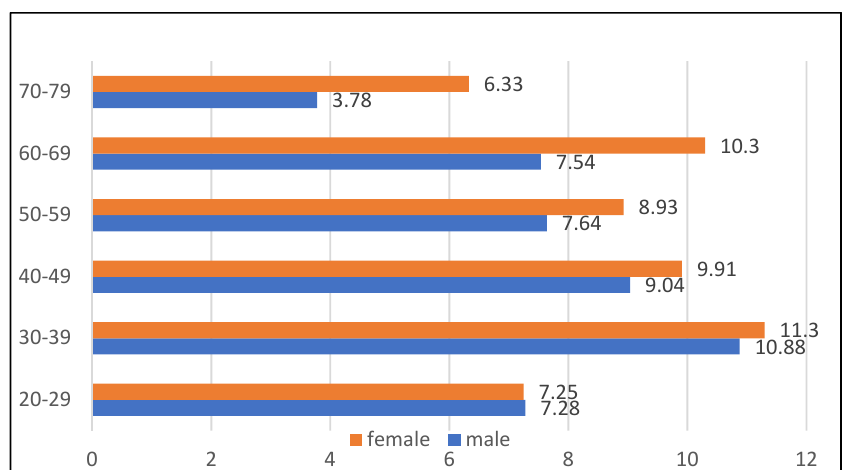
Figure 1. The distribution of the population drawn for the survey by age and sex.